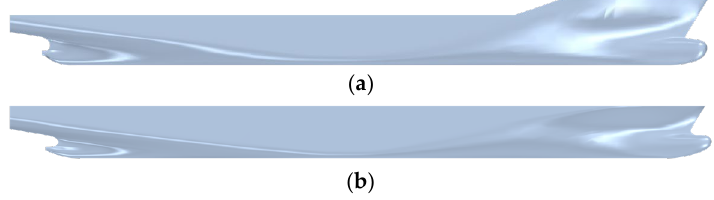
Figure 1. Hull geometries of the two ships. ( a ) KCS, ( b ) Neo-Panamax. Table 1. Main particulars of the two ships.